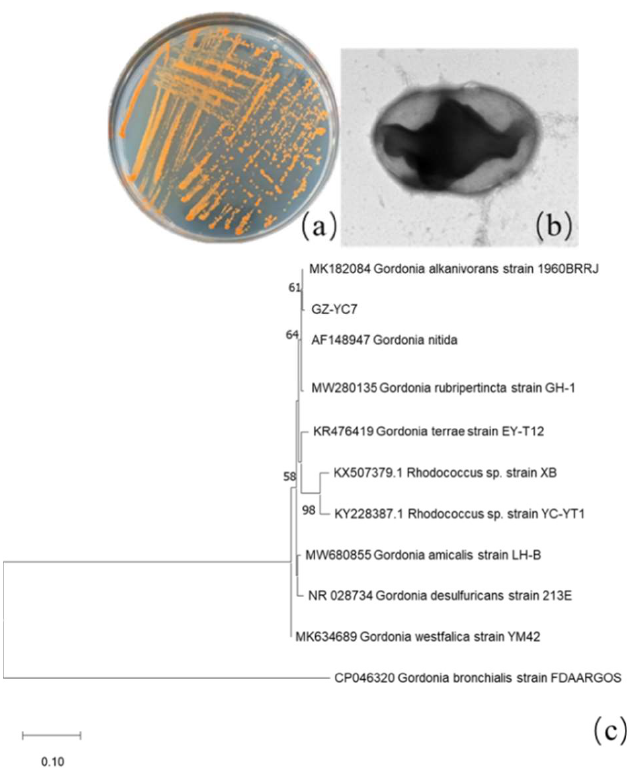
Figure 1. GZ-YC7 morphology of ( a ) colonies on the LB solid plate, ( b ) cell under TEM (60,000 × ), ( c ) phylogenetic tree analysis based on 16S rRNA sequences, Neighbor-Joining method with a boot- strap value of 1000.